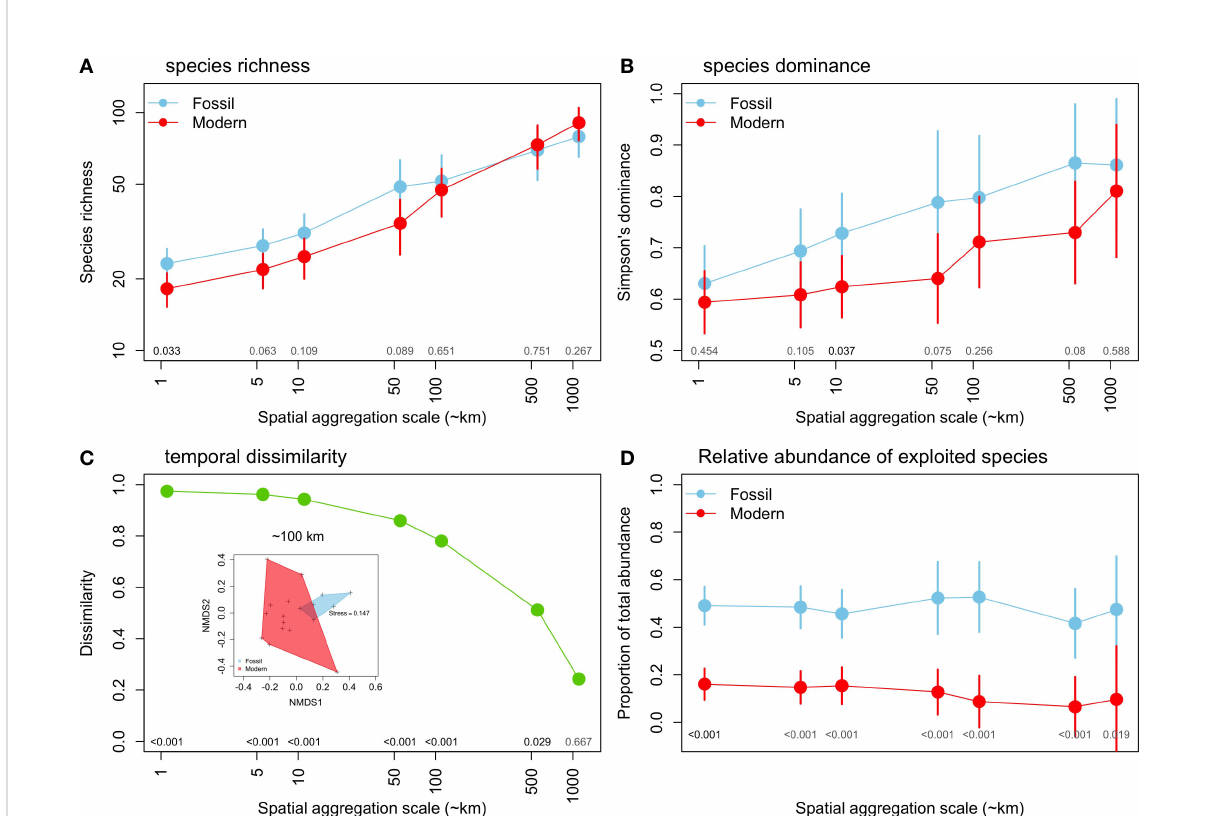
FIGURE 4 Changes in the diversity of mollusk assemblages between fossil and modern assemblages across different spatial aggregation scales: (A) coverage-based species richness, (B) species dominance (Simpson index), (C) Median dissimilarity (Chao index), with a nMDS illustrated for ~100 km aggregation scale, and d) relative abundance of exploited species. (A, C, D) based on meta-analysis mean values and 95%